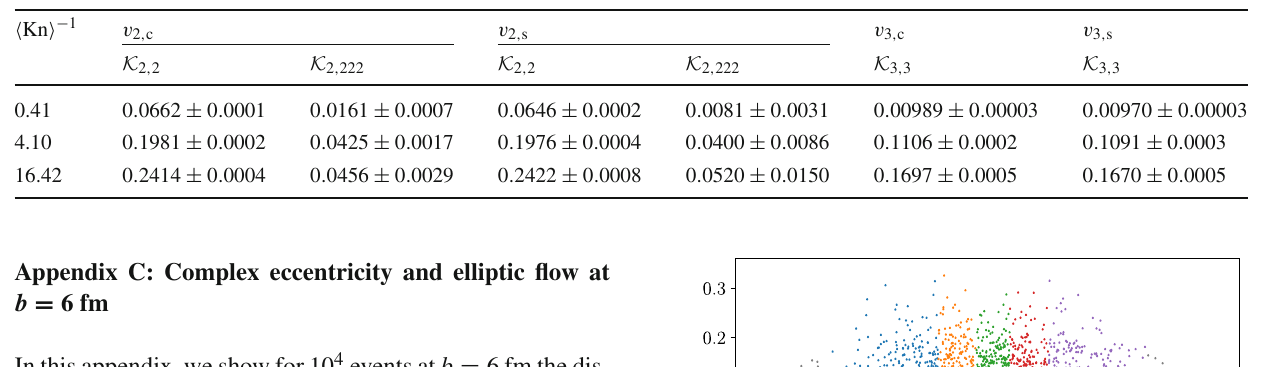
Table 8 Parameters of the fit functions for v 2 , c / s [nonlinear fit Eq. (5)] and v 3 , c / s [linear fit Eq. (4)] at b = 9 fm